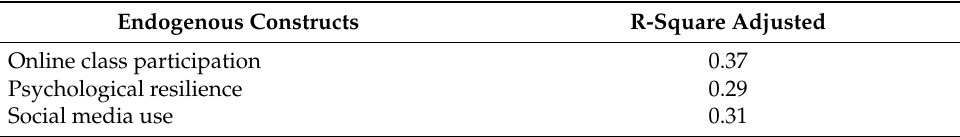
Table 4. Coefficient of determination (R 2